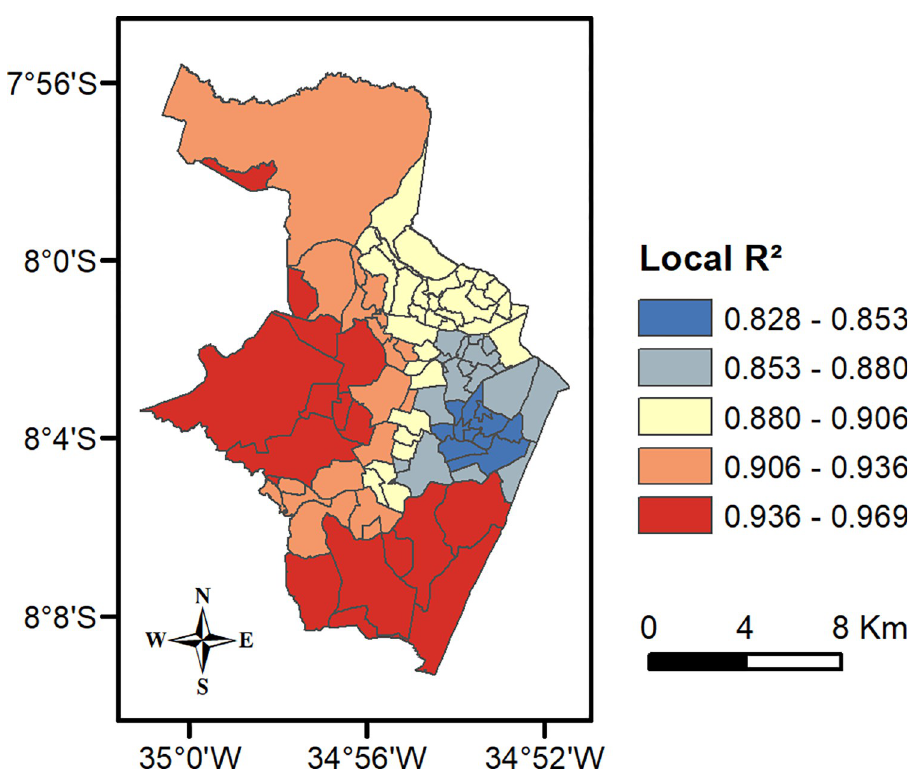
Fig 6. Performance of local R 2 across the neighborhoods of Recife city. Sources: Brazilian Institute of Geography and Statistics (IBGE) 2021, and software ArcGIS 10.4.1.